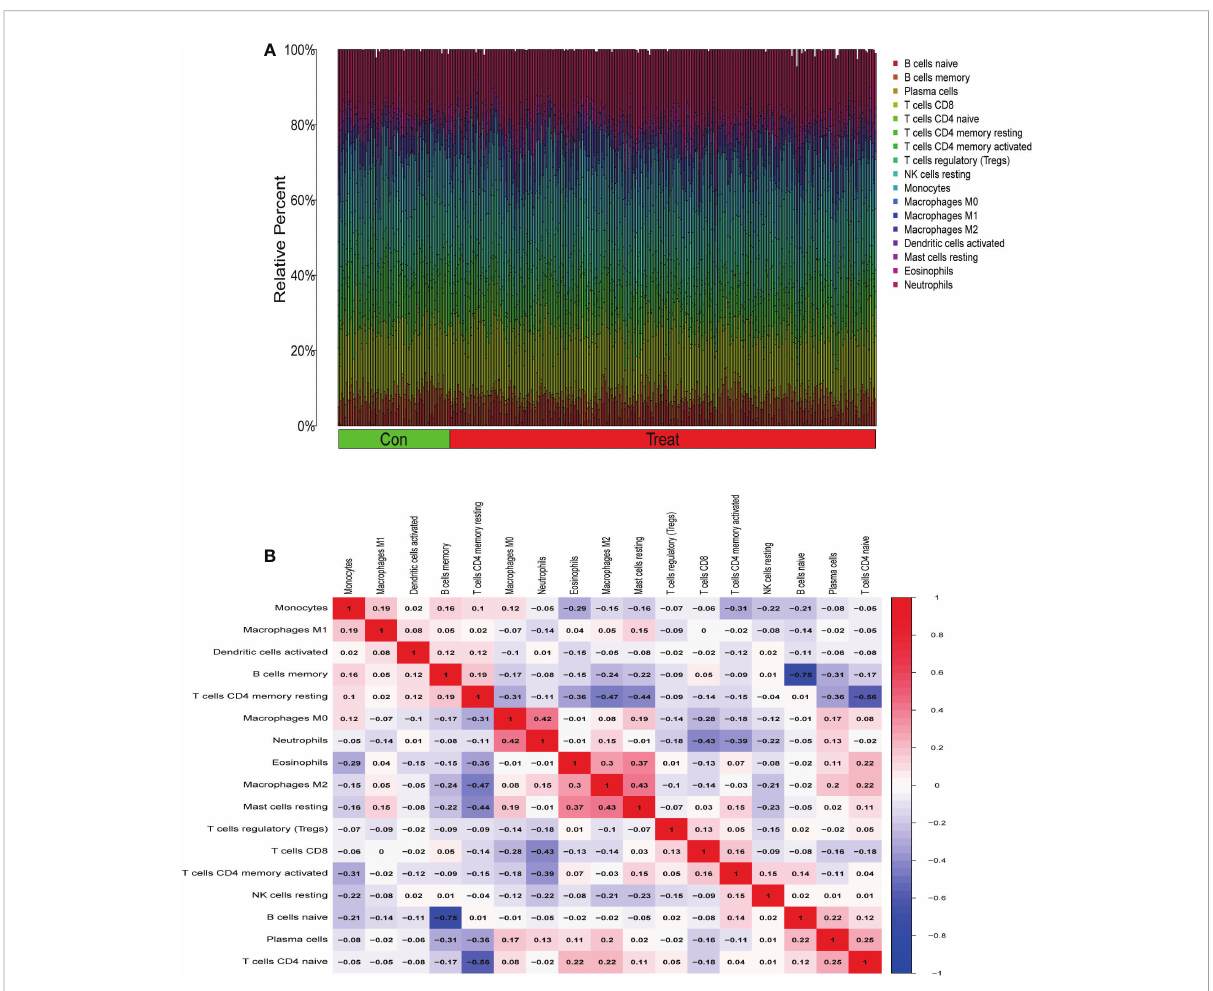
FIGURE 5 Immune in fi ltration analysis. (A) Immune cell distribution map. (B) Correlation of immune cells between patients with in fl ammatory bowel disease (IBD) and normal